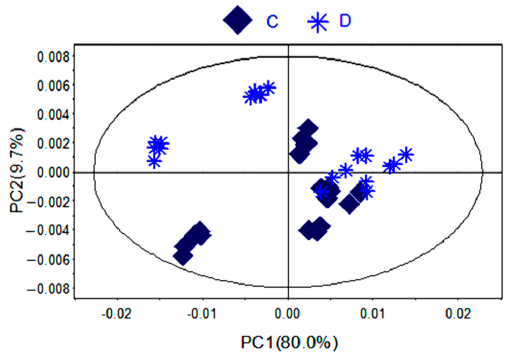
Figure 4. PCA scores plot of PR from different germplasms ( C ) zs; ( D ) jr. Table 2. Significant differences in the chemical compositions and the correlation coefficient.